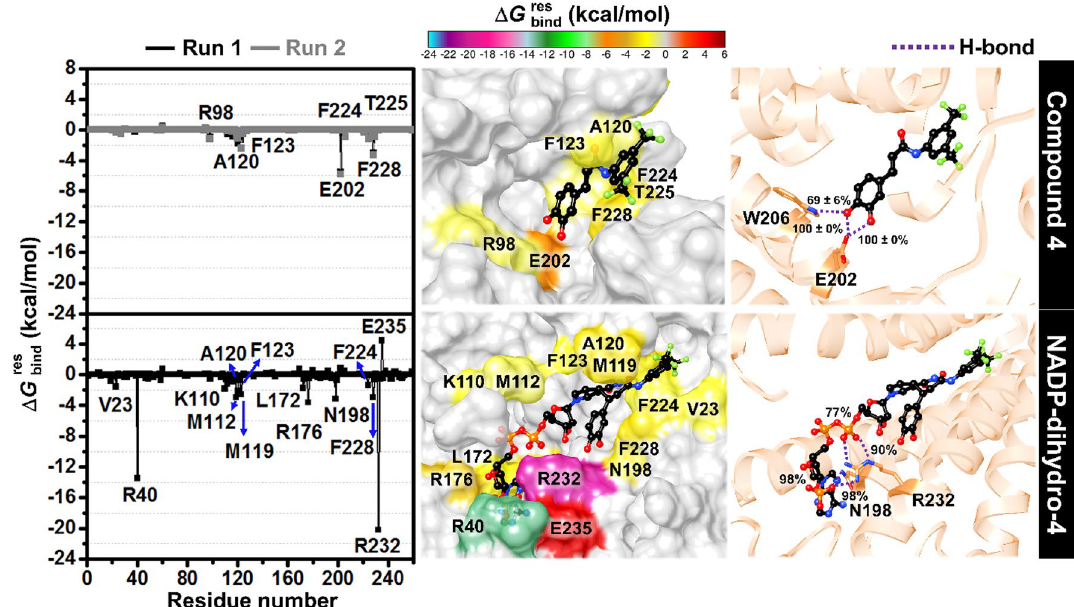
Figure 12. Per-residue decomposition free energy of the SRD5A1 in complex with compound 4 (Average data from Runs 1 and 2) and NADP-dihydro- 4 (Run 1) and hydrogen bond occupation (cut off > 65%) from the last 100 ns MD simulation. The lowest and highest energies range from cyan to dark red, respectively. The representative frame of the most frequent binding of each complex resulted from RMSD clustering using Chimera 1.15 48 is